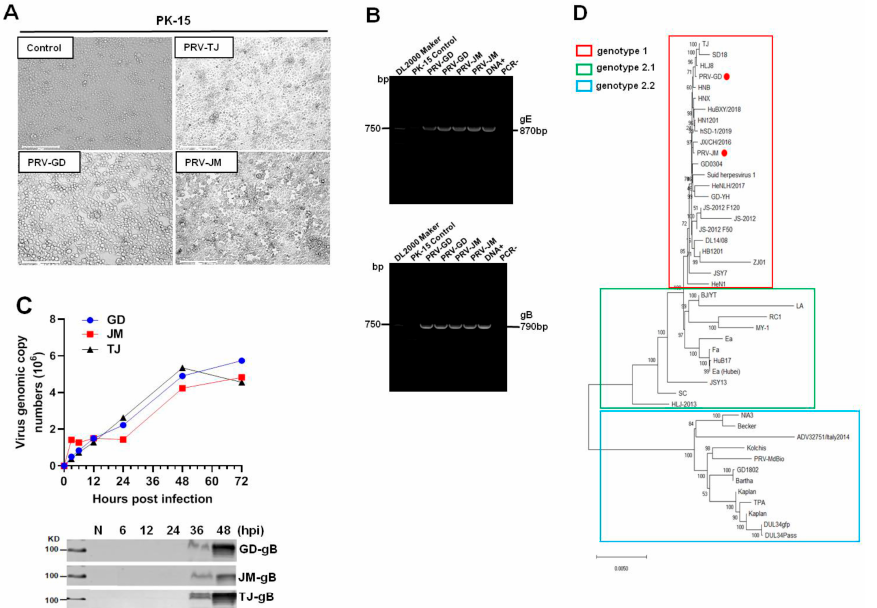
Figure 1. Isolation and identification of PRV-GD and PRV-JM isolates. ( A ), The cytopathic effects (CPEs) of PK-15 cells infected by PRV-GD and PRV-JM for 24 h. The CPEs of PK-15 cells infected with PRV-TJ strain were considered as the positive control. The arrowhead indicates the CPEs observed of PRV-GD and PRV-JM-inoculated PK-15 cells. The CPEs were characterized with rounded and floated cells. ( B ), PCR amplification of PRV gE (870 bp) and gB (790 bp) fragments from PRV-GD and PRV-JM-inoculated PK-15 cells. DNA+ was the positive control and PCR − was the negative control during PCR amplification. ( C ), One-step growth curves and gB protein assessment of 3 PRV strains on PK-15 cells at a multiplicity of infection of 0.1. ( D ), Phylogenetic tree based on genomic nucleotide sequence. PRV-GD and PRV-JM isolates in this work were indicated with a red dot. The phylogenetic tree was constructed by the adjacency method in MEGA 7 (http://www.megasoftware.net, accessed on 14 July